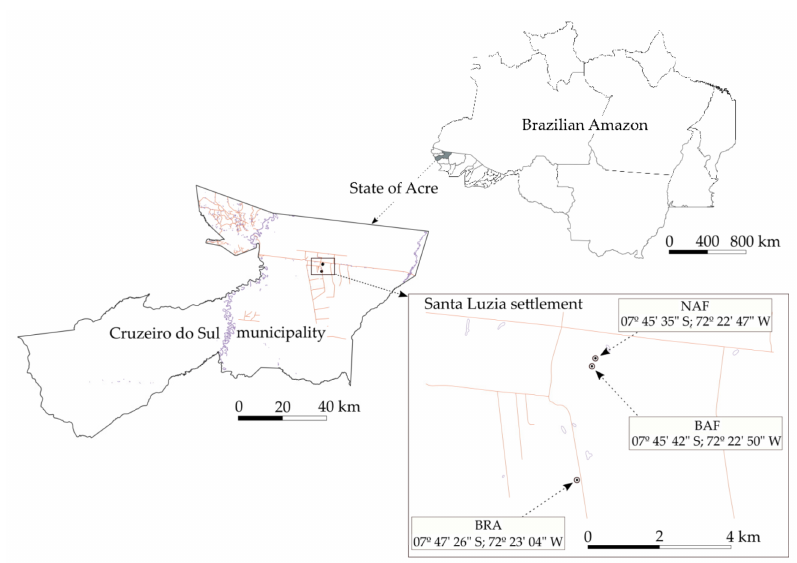
Figure 1. Location of the evaluated sites: native Amazon Forest (NAF), burned Amazon Forest (BAF) and Brachiaria pasture (BRA) in Cruzeiro do Sul city, Acre State, Brazil. Adapted from Leal et al. [15] based on a CC_BY license